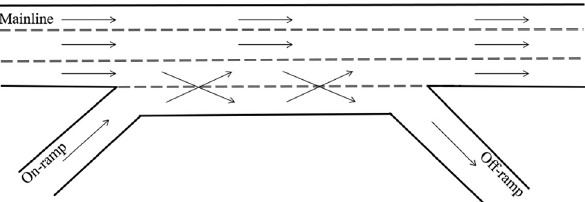
Figure 1 Traf fi c weaving schematic in the weaving area